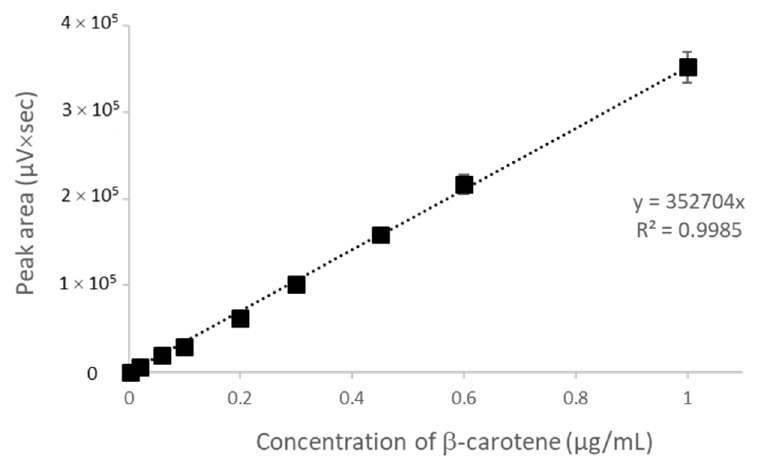
Figure 1. Calibration curve for β‐ carotene determination by HPLC using a C 18 column.